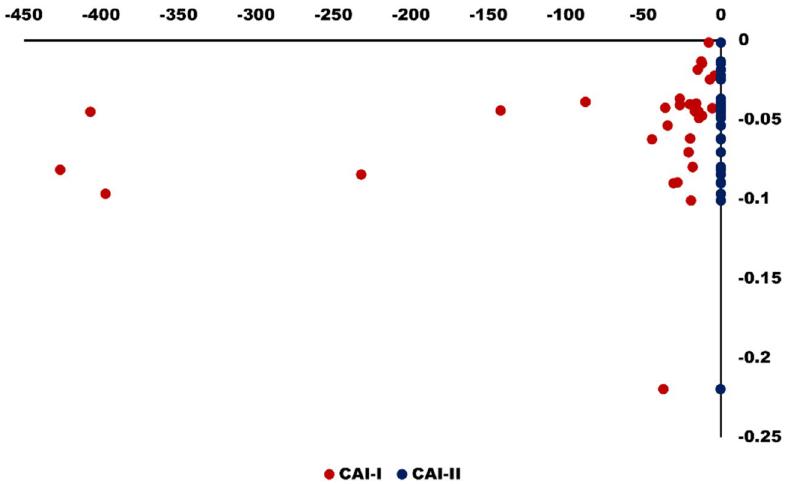
Figure 12. Scatter diagram shows the variation of chloro- alkaline indices of surface water samples in the study